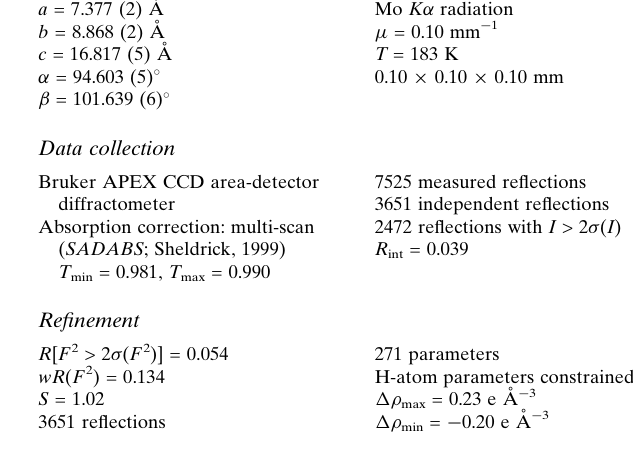
Data collection Bruker APEX CCD area-detector diffractometer